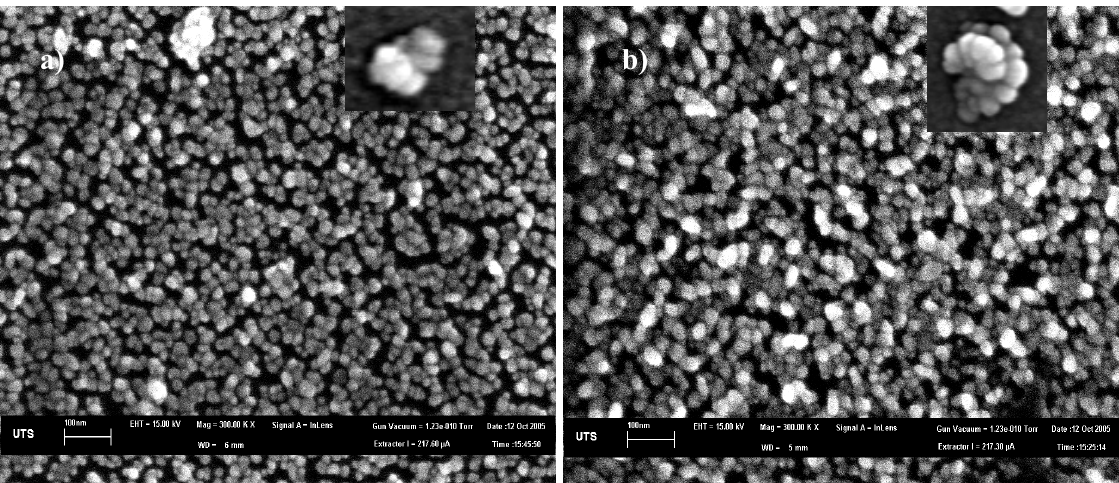
Figure 5. An SEM image of (a) Au-core Ag-shell nanoparticles after 1 minute